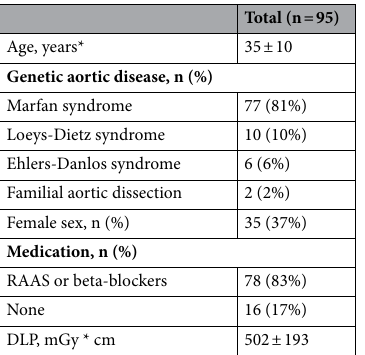
Table 1. Baseline data of patients included in this study. RAAS, renin–angiotensin–aldosterone system; DLP, dose-length